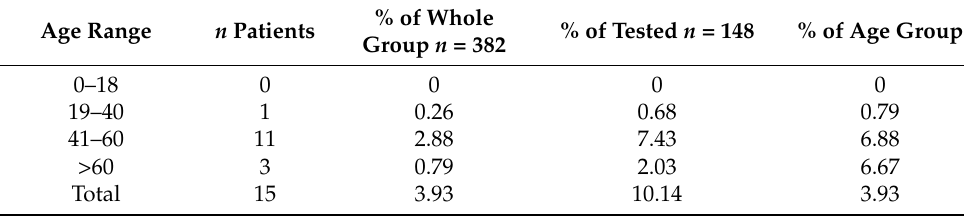
Table 3. The proportion of patients with an elevated basal tryptase level according to age